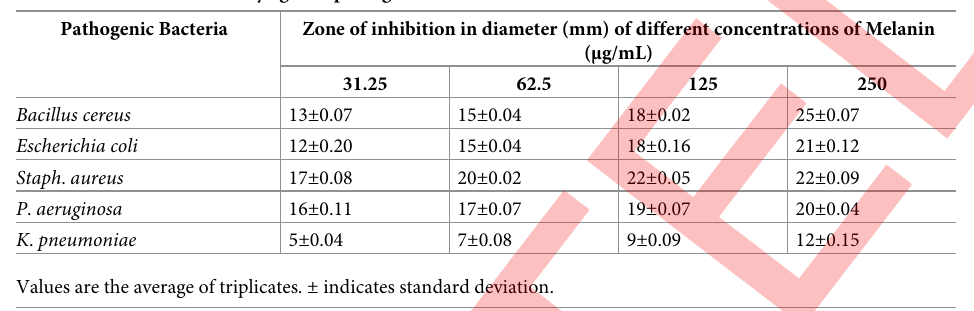
Table 1. Antibacterial activity against pathogenic bacteria. Pathogenic Bacteria